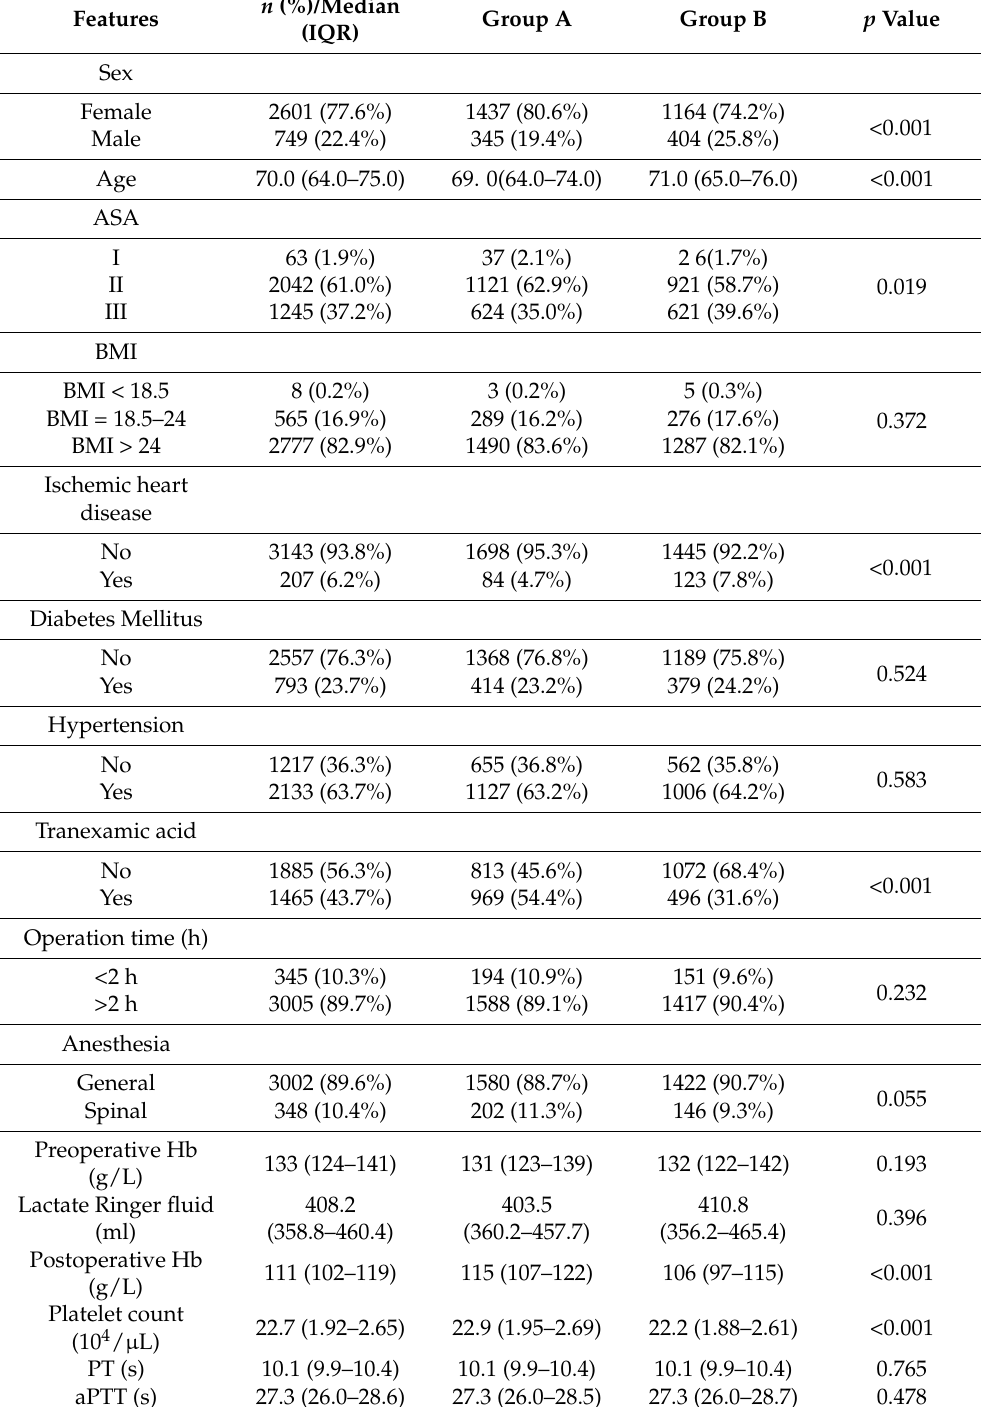
Table 1. Demographic and characteristic features of patients undergoing total knee